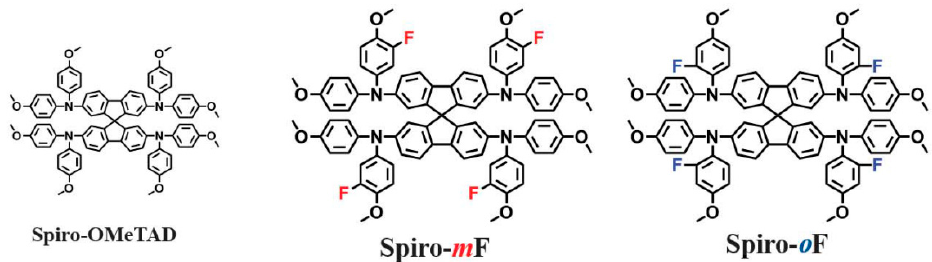
Figure 6. Chemical structures of Spiro-OMeTAD and its fluorinated analogs Spiro-mF and Spiro- oF. Copyright Reproduced with permission from Reference [62]. with permission from Reference